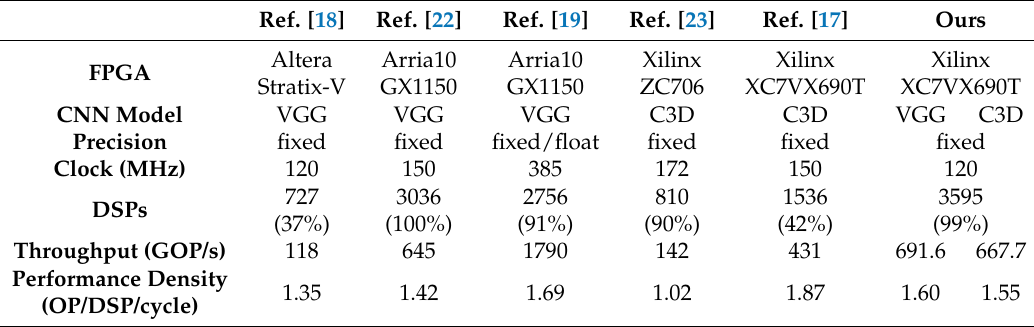
Table 5. Comparisons with previous accelerator